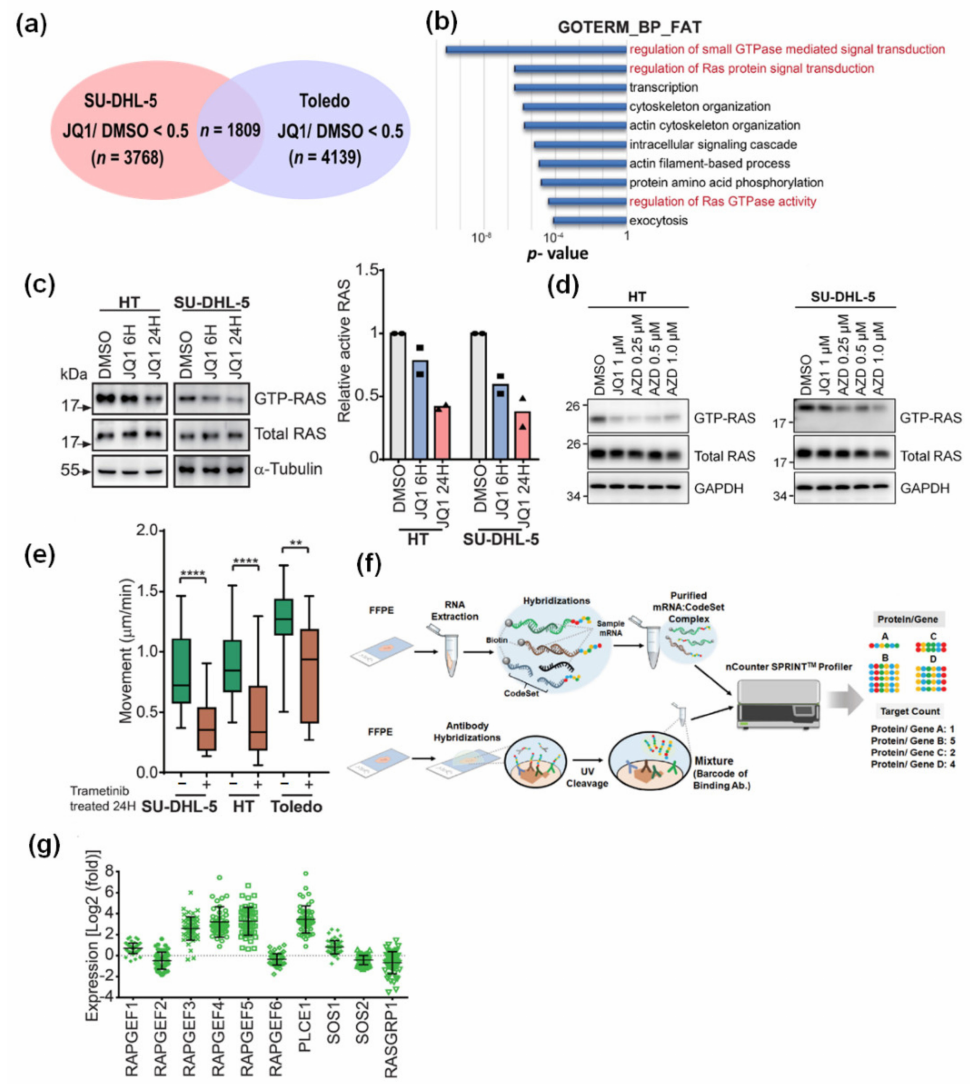
Figure 3. BET inhibition diminishes RAS activity in DLBCL cells. ( a ) A schema illustrating the mining process for the identification of relevant signal pathways affected by BET inhibition. SU-DHL-5 and Toledo cells were treated with either DMSO or JQ1 1 µ M for 8 hours and then subjected to RNA sequencing. The cutoff ratio of relative gene expression levels comparing JQ1- versus DMSO- treated cells was set at less than 0.5. ( b ) Gene Ontology-Gene function classification (Biological Process) database analysis. Several key signaling signatures differentially inactivated in JQ1-treated cells were listed. ( c,d ) Pull-down assay and Western blotting demonstrating RAS activity in DLBCL cells treated with BET inhibitors. Cells were treated with either JQ1 (concentration 1 µ M) or AZD5153 at indicated concentrations for indicated time periods, and cell lysates were harvested for further analysis. Representative blots from three independent experiments were shown. ( e ) Quantification of movement speeds of three DLBCL cell lines treated with trametinib 100 nM ( n = 10). ** p < 0.01, **** p < 0.0001, by Student’s t -test. Two biologically independent experiments were performed with consistent results, and the data shown here were from one representative experiment. ( f ) A schema demonstrating barcoded mRNA and protein analysis in tumor tissues from a cohort of DLBCL patients treated with immunochemotherapy. ( g ) Expression levels of several RASGEF genes in DLBCL samples. Folds of expression were obtained through calculating the ratios between DLBCL samples and normal controls. RASGEF: RAS guanine nucleotide exchange